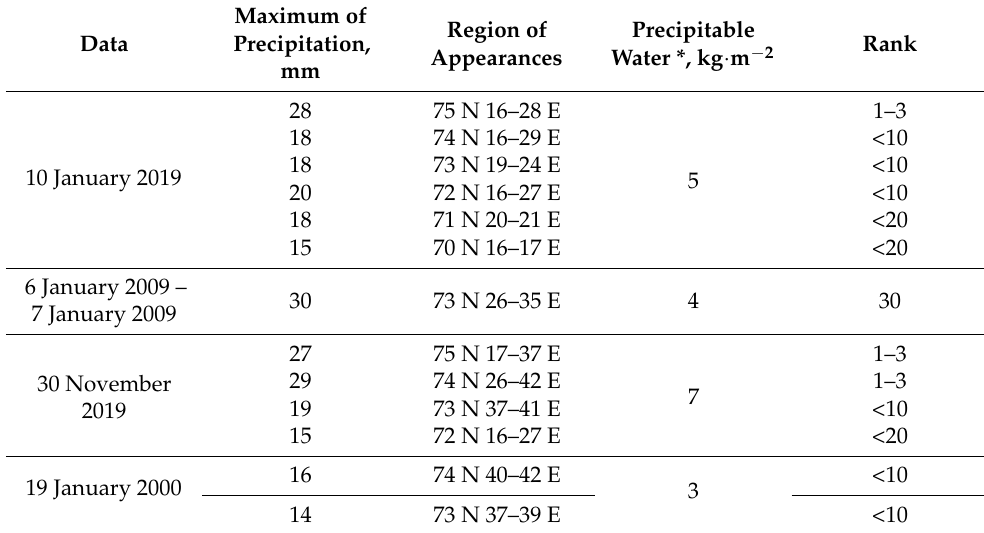
Table 2. Characteristics of precipitation extrema, discussed in the text. Maximum Data